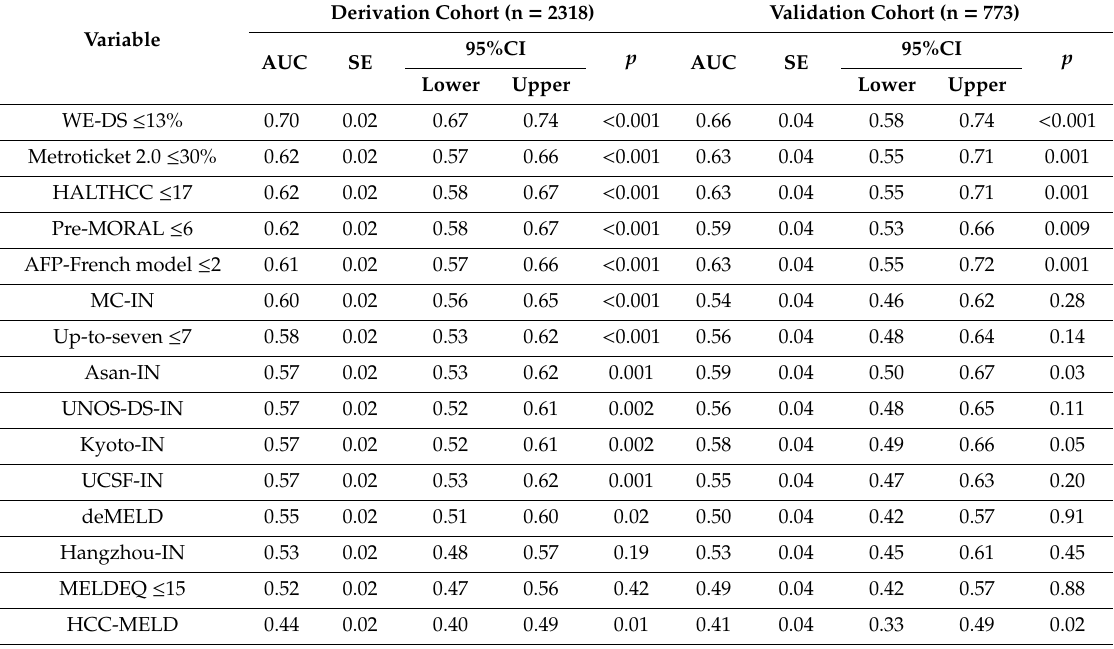
Table 3. Comparison between di ff erent scores for the prediction of post-transplant HCC-related death, in the Derivation (n = 2318) and Validation Cohort (n =